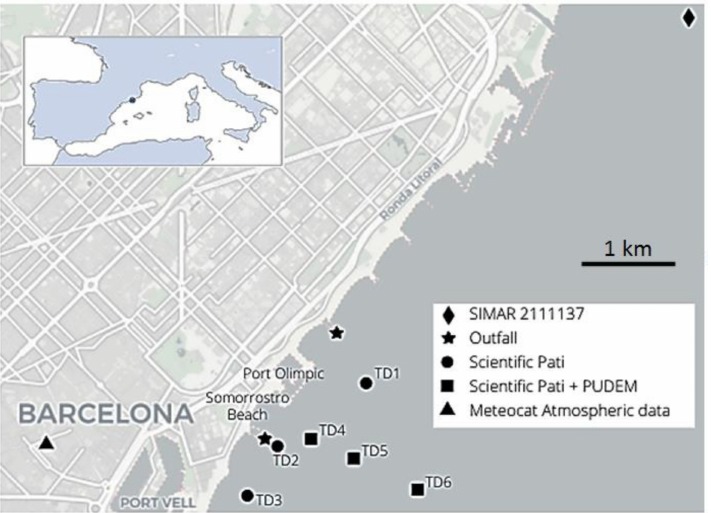
Figure 8. Study area off Barcelona with the location of the TD, wave and meteorological